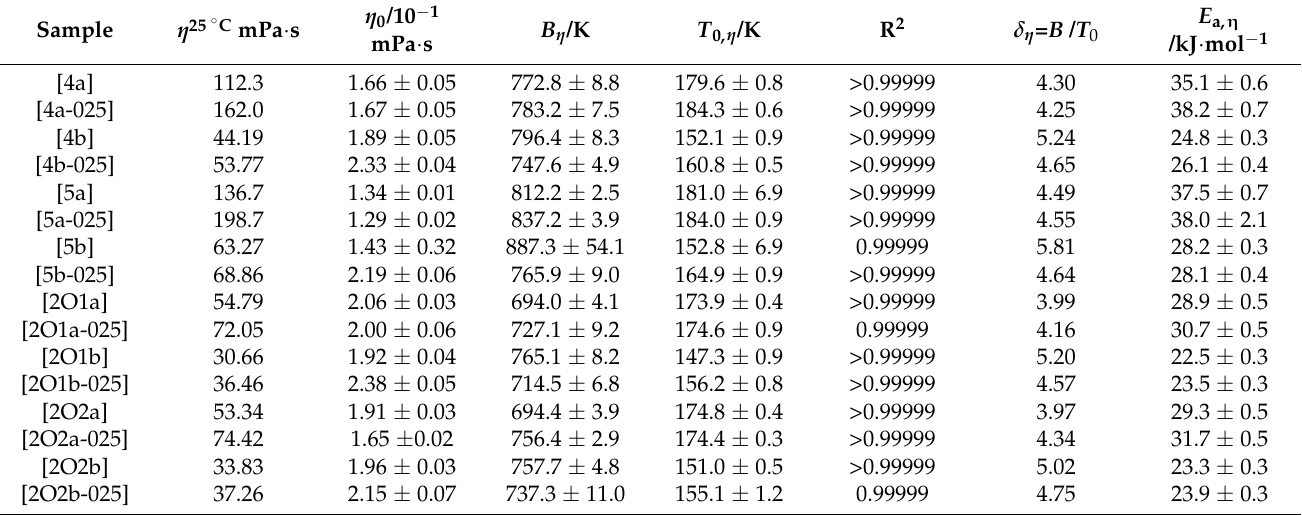
Table 4. Viscosity η at 25 ◦ C, VFT fitting parameters ( η 0 , B η , T 0, η ), Angell strength factor δ η and activation energy E a, η (in the range of 25 to 60 ◦ C) for the T -dependent viscosity data, following Equation